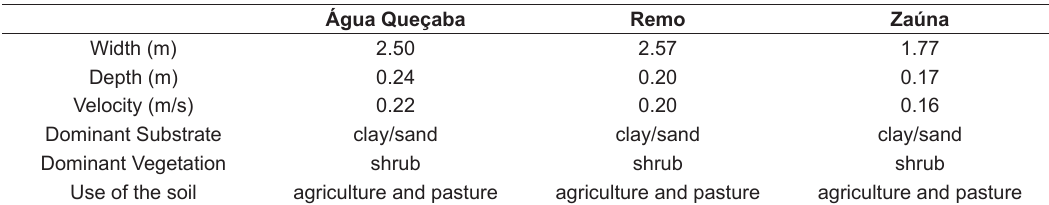
Table 1. Environmental characteristics at three streams of the sub-basin of the Pirapó River, upper Paraná River basin (mean